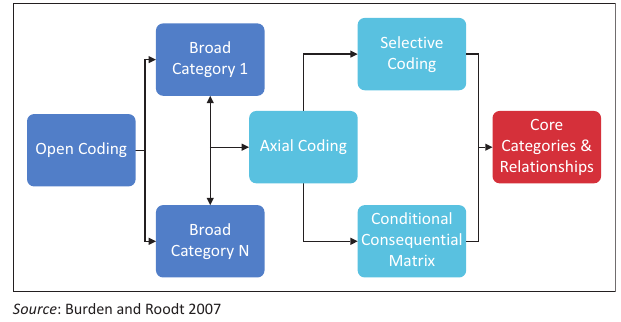
FIGURE 1: Iterative coding